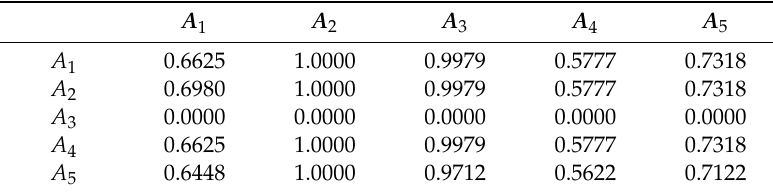
Table 12. Transformed probability of the alternative A 3 to A k .